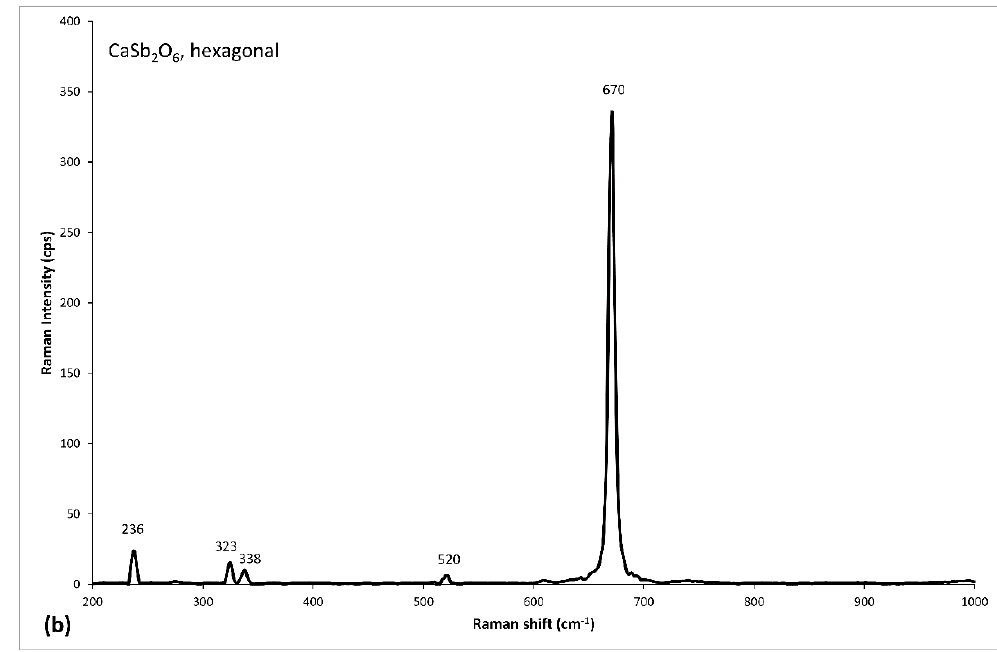
Figure 5 . Raman spectra, in the region from 200 to 1000 cm −1 , of Ca-antimonates identified in tessera TN TU3: note the presence of measured wavenumbers at 320, 370, 480 , 633 , 780, 830 cm −1 for CaSb 2 O 7 ( a ) and at 236, 323, 338, 520, 670 cm −1 for Ca 2 Sb 2 O 6 ( b ) (most intense signals in bold; reference spectra from [46,47]). Both phases, with a prevalence of the hexagonal one, are also detected in TN AQ1, TN AQ2, PN TU2, TN BO1, TN BIOP1, TN GR1, TN GR2, PN VCH1; the hexagonal phase is only detected in PN AZ2, TN AZ1, TN AZ2, TN TU2 and TN CE1.